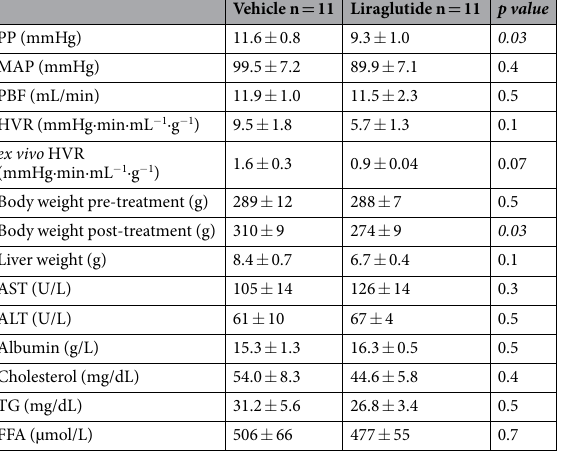
Table 1. Effects of Liraglutide on hepatic and systemic hemodynamics, and biochemical parameters in rats with chronic liver disease due to chronic TAA administration, represented as mean ± s.e.m. PP, portal